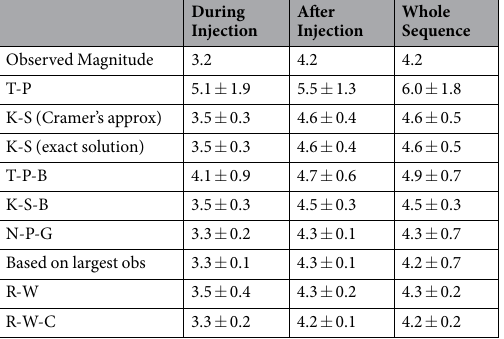
Table 4. Summary of M max estimations for each analyzed period with the different approaches applied together with the observed ones in each period (first line in the Table).